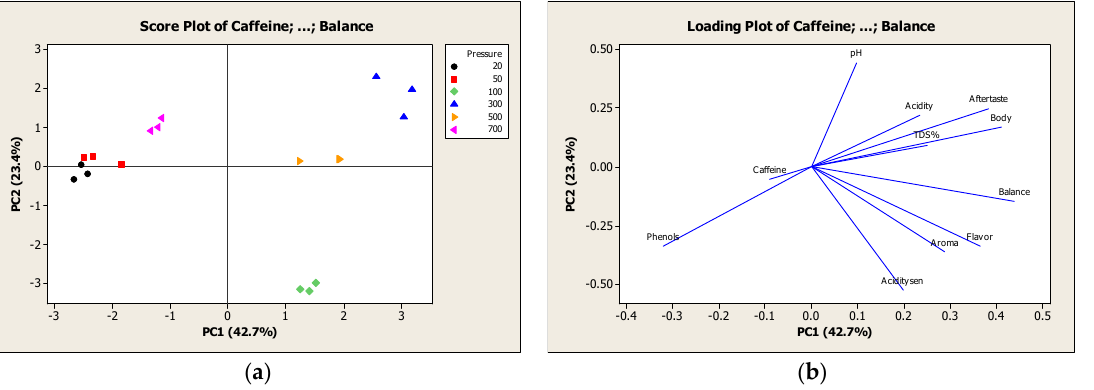
Figure 5. ( a ) Score plot of physicochemical and sensory properties in experiments with variation of pressure; ( b ) Loading plot of physicochemical and sensory properties in experiments with variation of pressure.